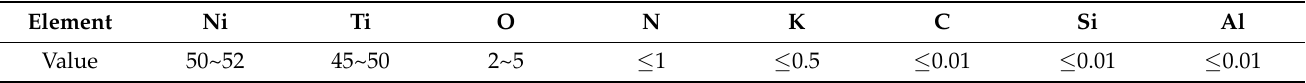
Table 3. The performance parameters of Ni-Ti alloy.